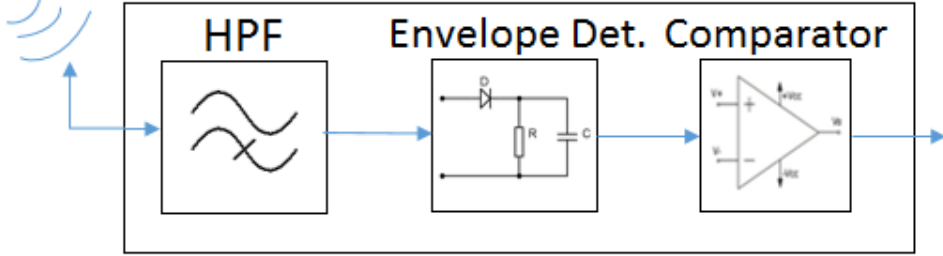
Figure 5. Main composition of WuRx.